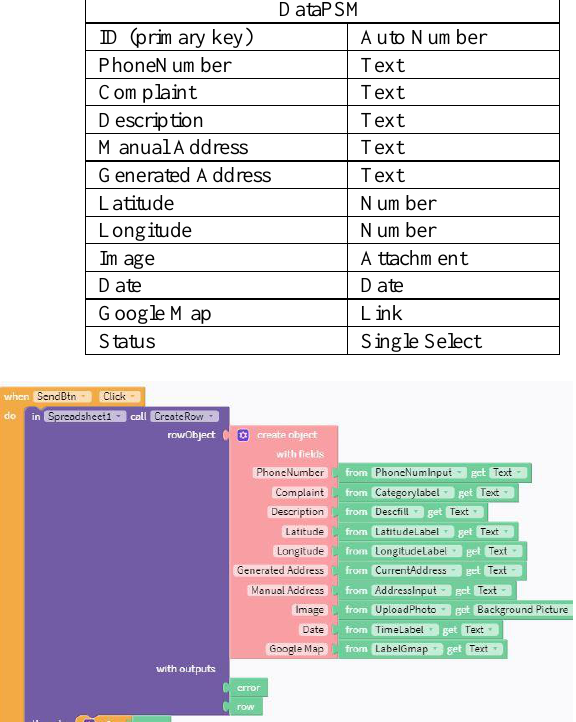
Figure 6. Drag and drop block to connect data input with